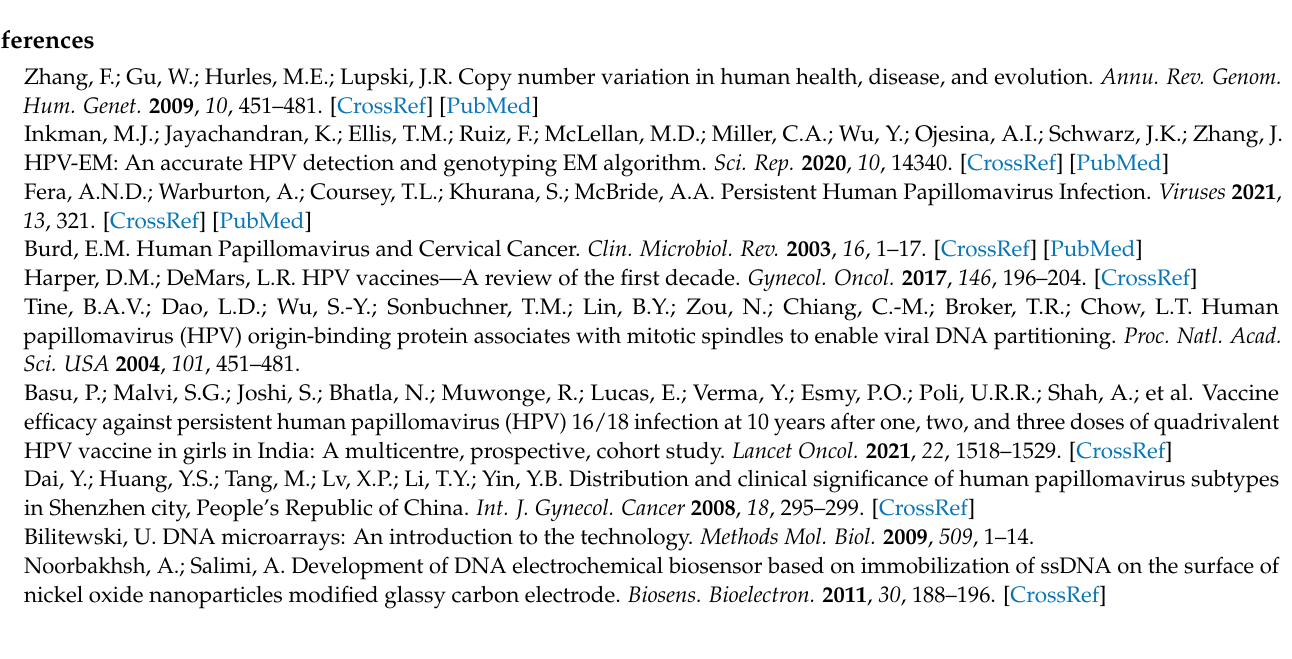
Program’ Table S2: Denaturation Program; Table S3: Composition of